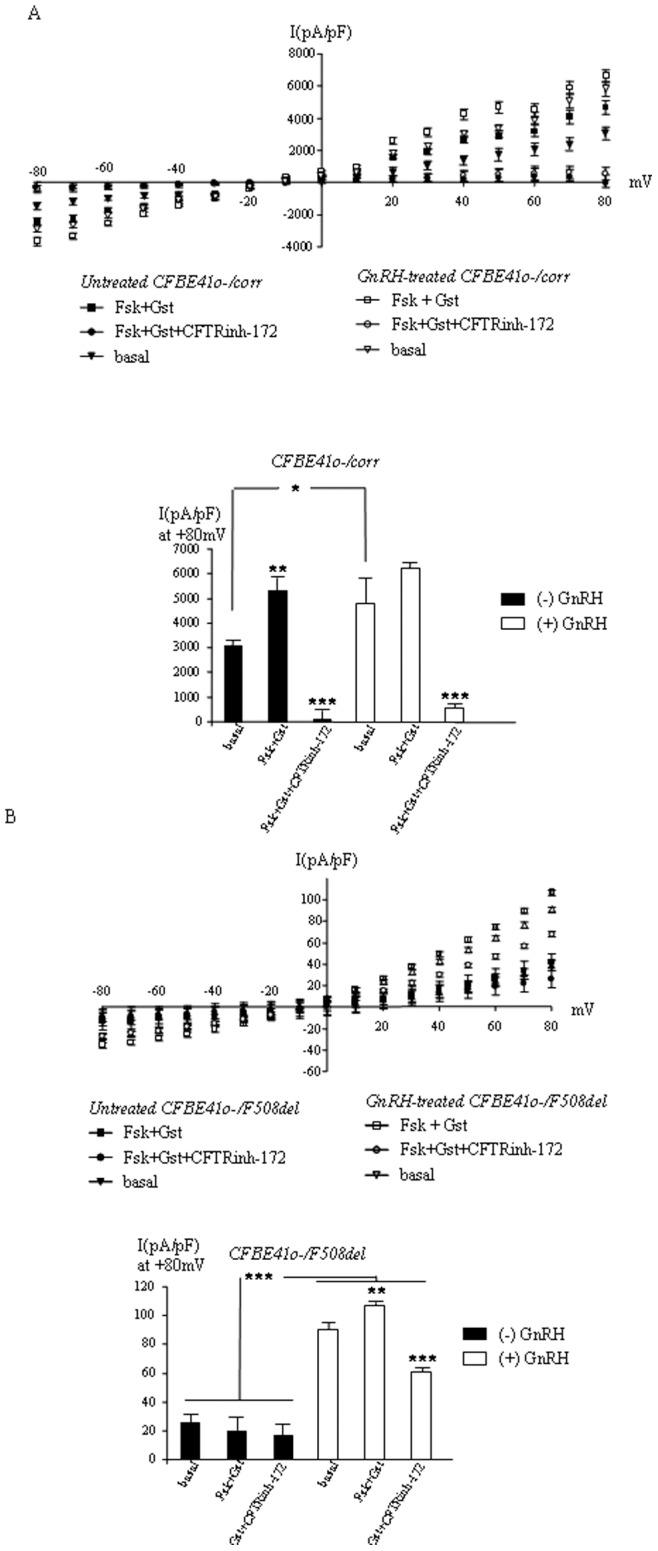
Activation of CFTR current in CFBE41o−/corr and CFBE41o−/F508del cells by patch –clamp experiments.
A. Upper panel shows I/V curves (normalized by cell capacitance pF, mean±SEM) for CFTR current in CFBE41o−/corr cells in the whole cell configuration. Basal condition is with MgATP in the intracellular buffer. CFTR was activated by forskolin plus genistein and inhibited by CFTR inhibitor 172. Curves obtained with and without GnRH treatment (1 hour) were plotted. The lower panel shows the statistical analysis of the currents noted at +80 mV. B. Same as in A for CFBE41o−/F508del cells.